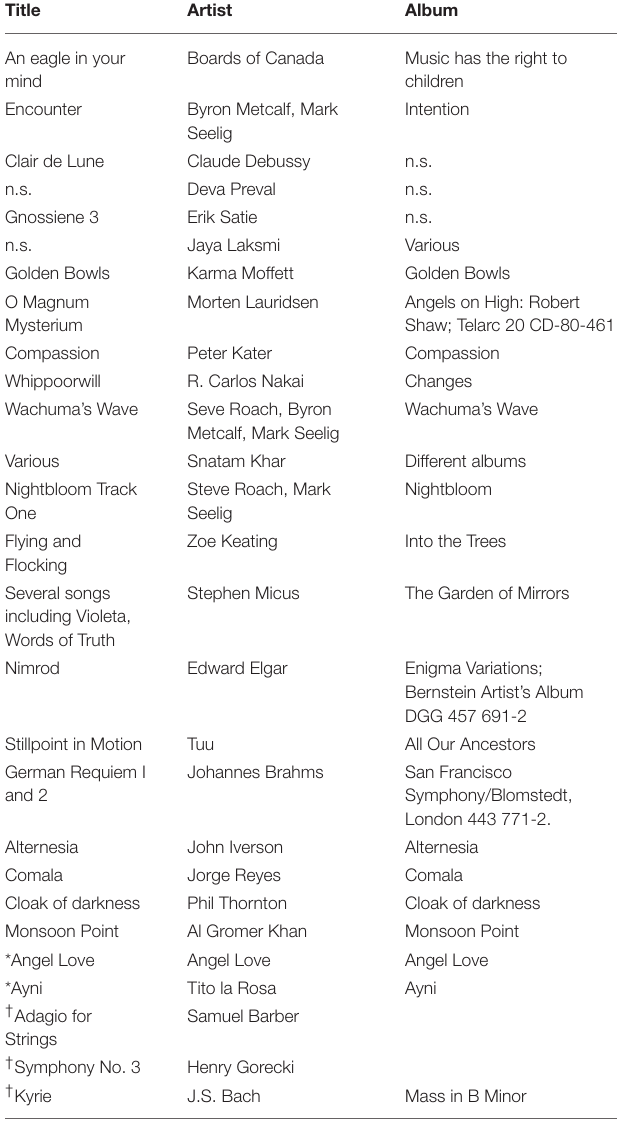
TABLE 3 | Stimuli recommended for pre peak